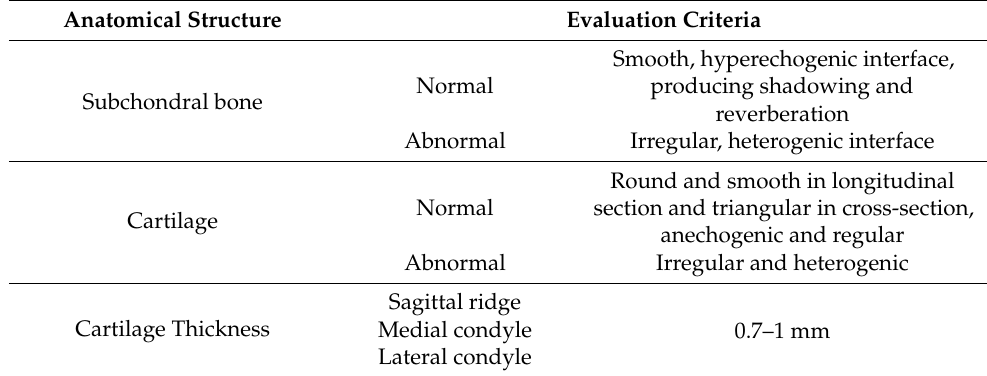
Table 1. Evaluation criteria applied for the ultrasound appearance assessment. Anatomical